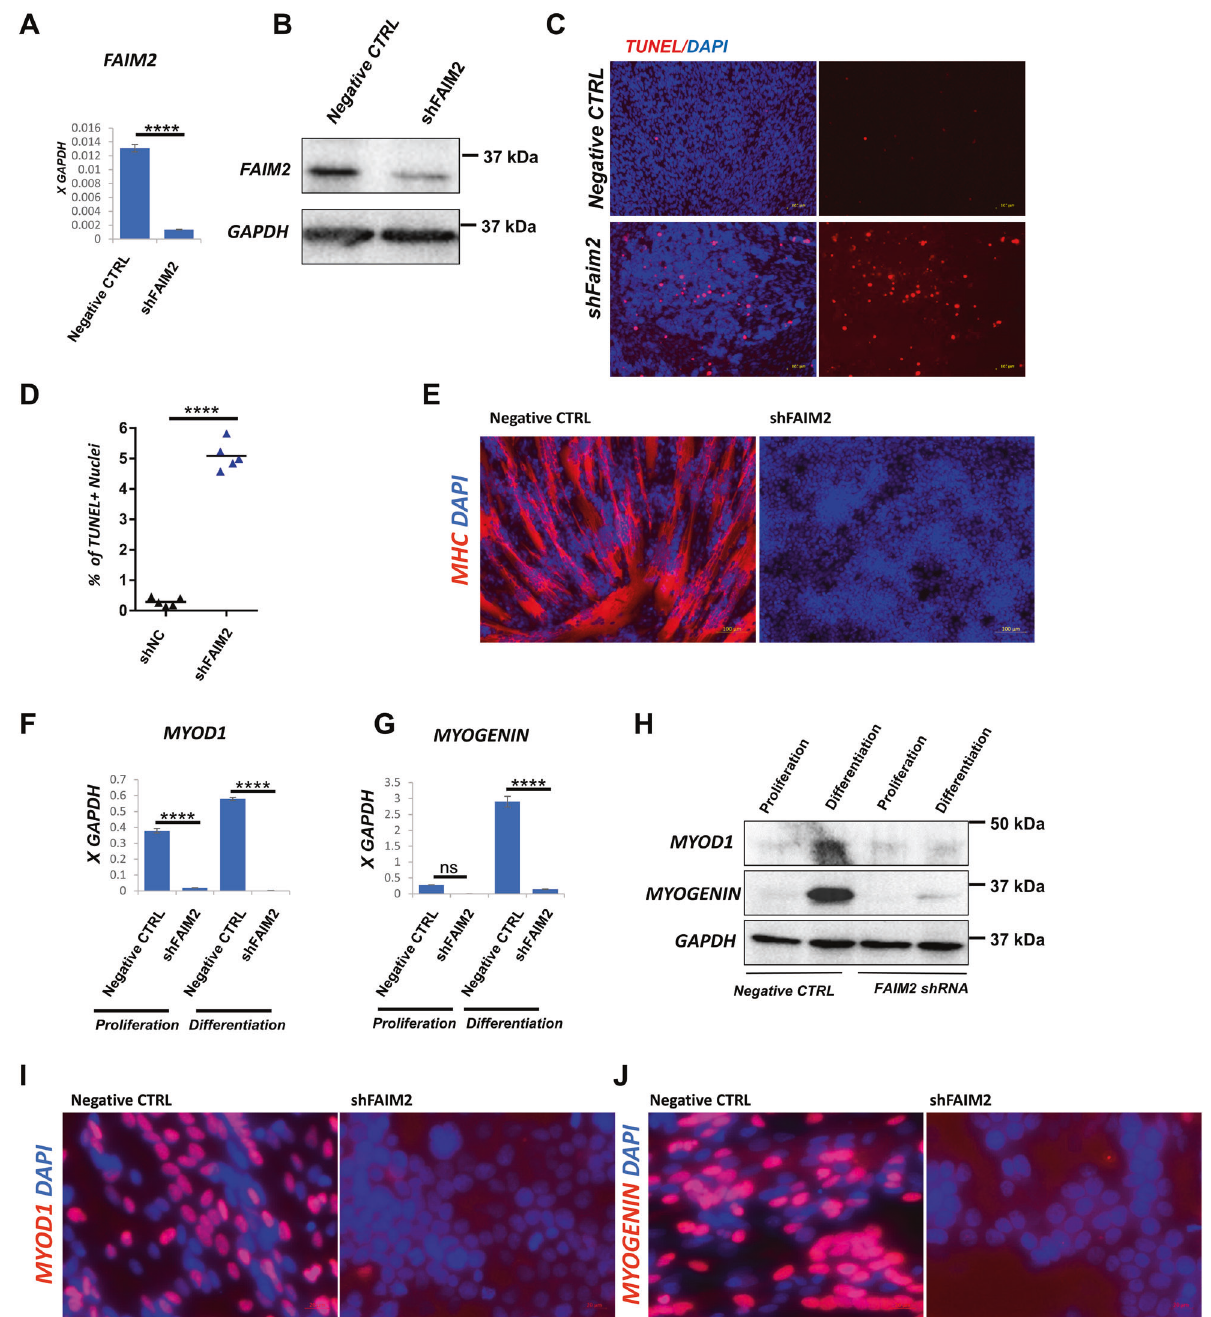
Fig. 5 shRNA knockdown of FAIM2 promotes myoblast apoptosis and blocks myogenic differentiation. A RTqPCR for FAIM2 expression in LHCN-M2 myoblasts transduced with a lentivector expressing shRNA targeting FAIM2 or empty vector control. Data are presented as mean ± SEM; **** P < 0.0001, by unpaired t -test ( n = 3). B Western blot analysis of FAIM2 expression in shRNA knockdown and control LHCN-M2 myoblasts, as in A. C Immuno fl uorescent staining of TUNEL positive cells (red) and DAPI (blue) in shRNA knockdown (bottom) or control (top) LHCN-M2 myoblasts. D Frequency of TUNEL positive LHCN-M2 cells in shRNA knockdown or control LHCN-M2 myoblasts. Data were taken from Immuno fl uorescence images of fi ve different wells of each cell line. Data are presented as individual data points plus mean; **** P < 0.0001, by unpaired t -test ( n = 5). E Immuno fl uorescent staining for MHC (red) and DAPI (blue) in FAIM2 knockdown (right) or control (left) LHCN-M2 myoblasts, differentiated for 48 h. F RTqPCR for MYOD1 expression in FAIM2 knockdown and control LHCN-M2 myoblasts during proliferation or after 48 h of differentiation. Data are presented as means ± SEM; **** P < 0.0001 by two-way ANOVA with Tukey ’ s post hoc test ( n = 3). G RTqPCR for MYOGENIN expression in the same cells as in H . Data are presented as means ± SEM; for ns P = 0.1686, **** P < 0.0001 by two-way ANOVA with Tukey ’ s post hoc test ( n = 3). H Western blot analysis of MYOD1 and MYOGENIN expression in FAIM2 knockdown or control LHCN-M2 myoblasts during proliferation or after 24 h of differentiation. I Immuno fl uorescent staining of MYOD1 (red) and DAPI (blue) in FAIM2 knockdown or control LHCN-M2 myoblasts, differentiated for 48 h. J Immuno fl uorescent staining of MYOGENIN (red) and DAPI (blue) in FAIM2 knockdown or control LHCN-M2 myoblasts, differentiated for 48 h.